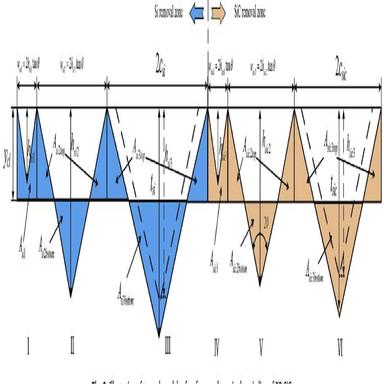
Set-up for grinding experiments.